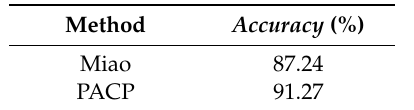
Table 7. Performance of two